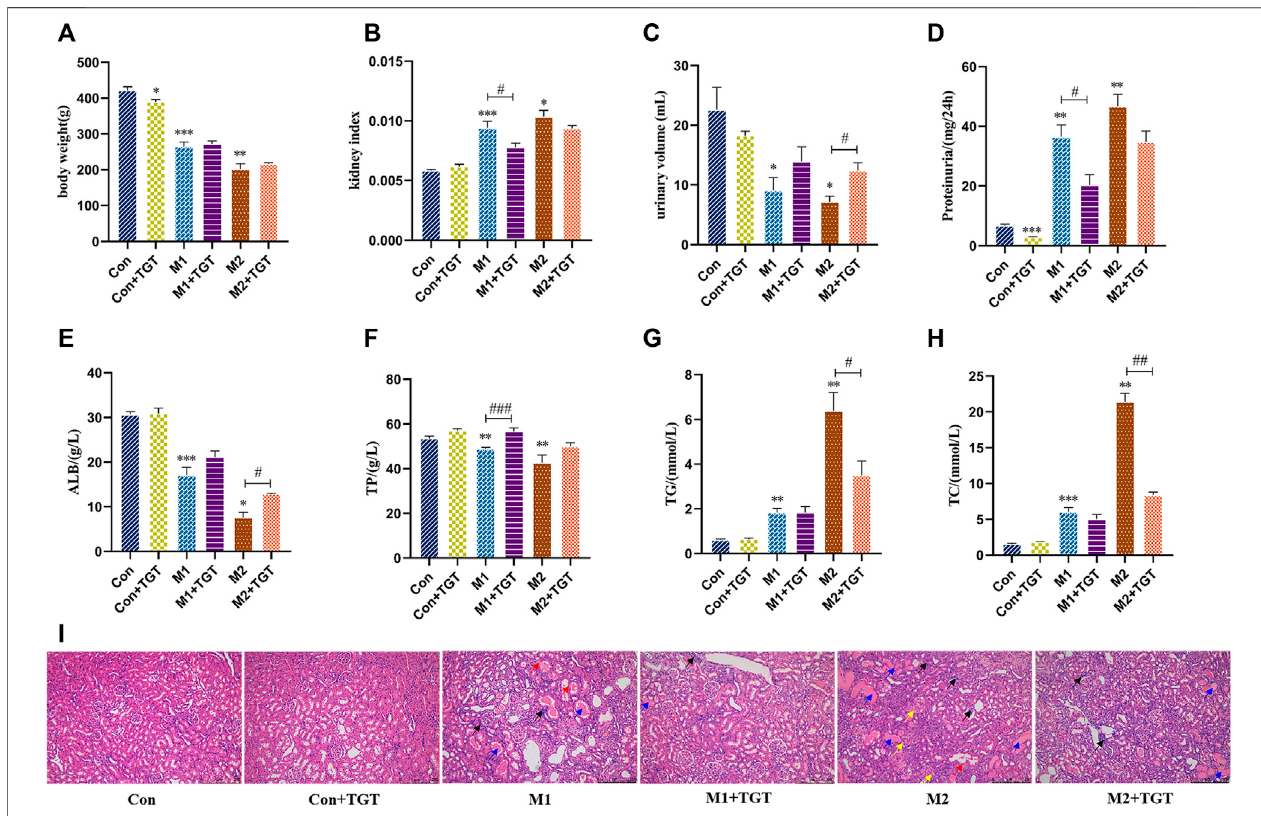
FIGURE 3 | TGT ameliorated the symptoms of NS and renal pathological injuries in adriamycin-induced-NS rats after TGT oral gavage dose of 10 mg/kg/day for 4 weeks (means ± SD, n = 7). The body weight (A) , the kidney index (B) , the urine volume (C) , the 24-h proteinuria (D) , the serum ALB (E) , the serum TP (F) , the serum TG (G) , and the serum TC (H) , * p < 0.05, ** p < 0.01, *** p < 0.005 versus Con, # p < 0.05, ## p < 0.01, ### p < 0.005 versus M1 or M2. HE staining of the same fi eld of section sample in kidney tissues (I) , interstitial in fl ammatory in fi ltrate (black arrow b ), protein casts (blue arrow ), degeneration of renal tubular epithelial cells (red arrow ), contraction of Bowman ’ s capsule (yellow arrow ) (magni fi cation: